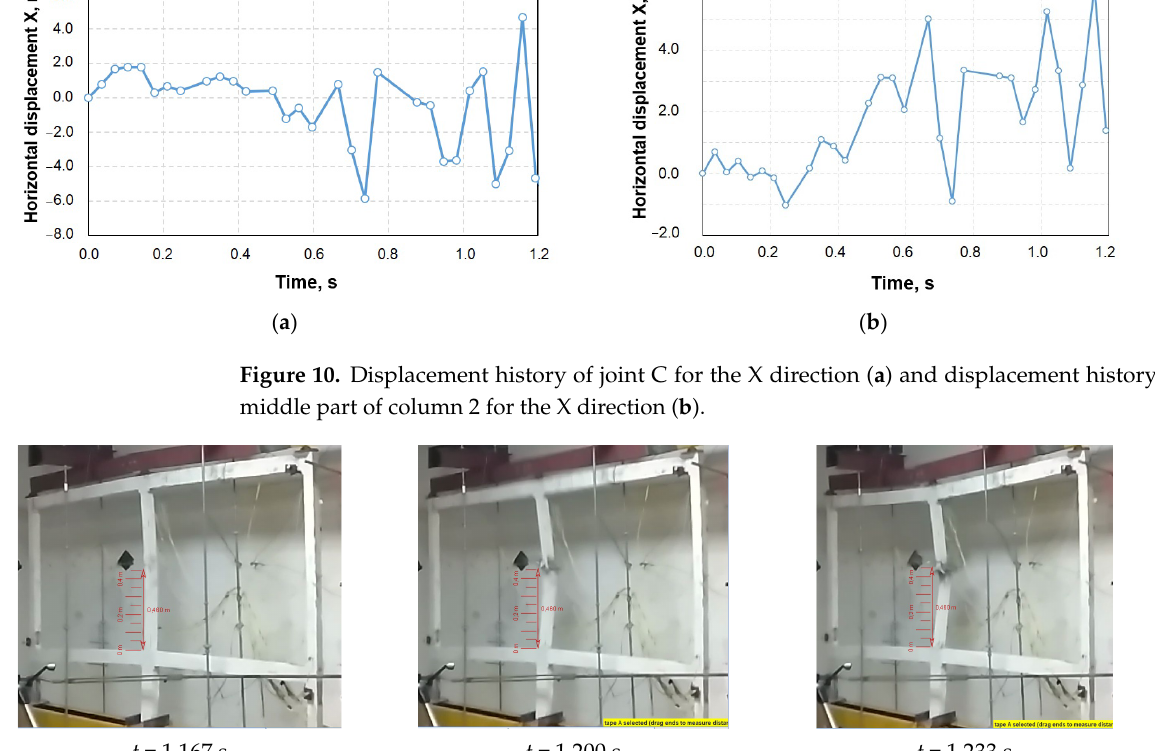
Figure 10. Displacement history of joint C for the X direction ( a ) and displacement history of the middle part of column 2 for the X direction ( b ).